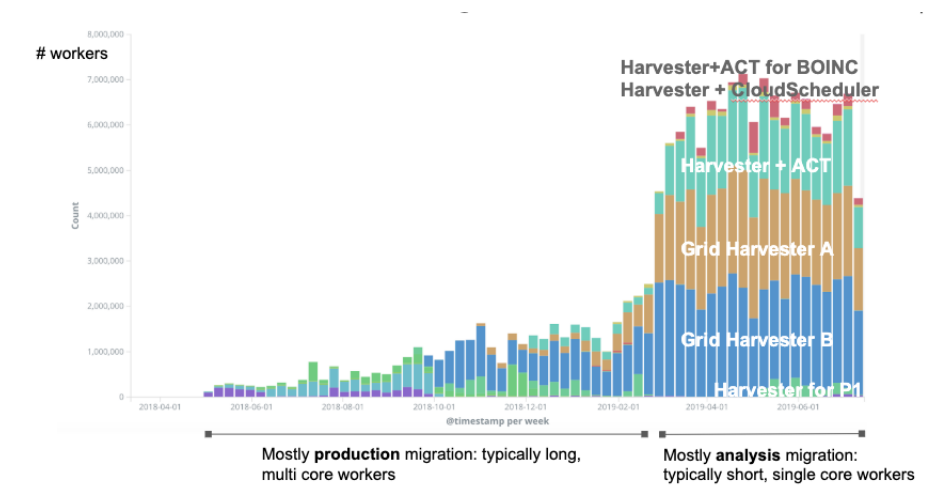
Fig. 2. Overview of the Grid migration progress to Harvester, in number of workers. This histogram is extracted from our Harvester worker monitoring.